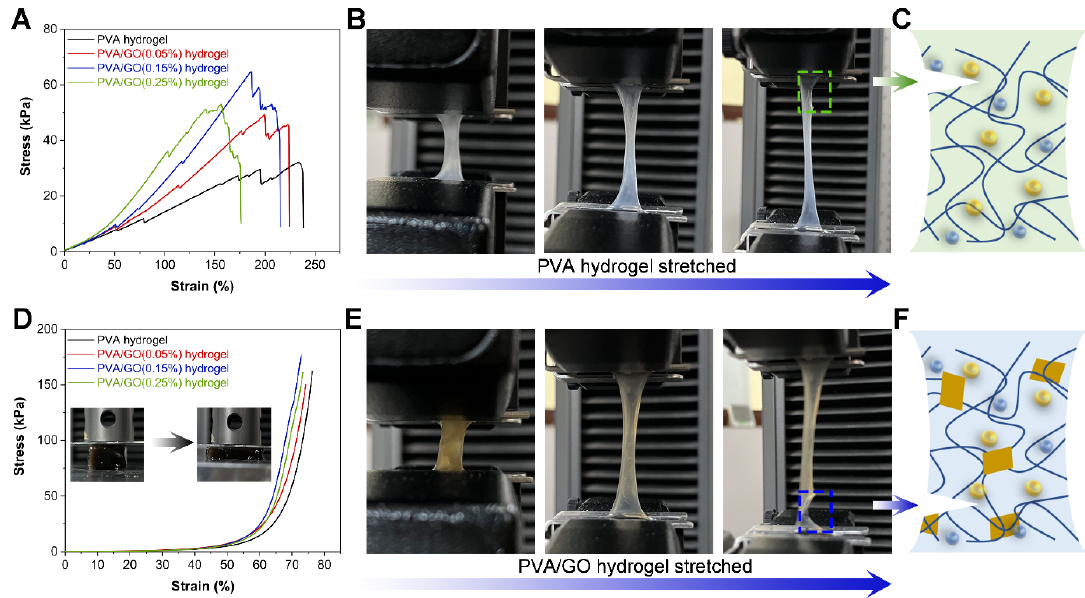
Figure 5. Mechanical properties of PVA/GO hydrogels with different GO contents. ( A ) Tensile stress–strain curves. ( B ) Tensile fracture process of PVA hydrogel. ( C ) Schematic diagram of ductile fracture mechanism of PVA hydrogel. ( D ) Compressive stress–strain curves. ( E ) Tensile fracture process of PVA/GO hydrogel. ( F ) Schematic diagram of enhanced ductile fracture mechanism of PVA/GO